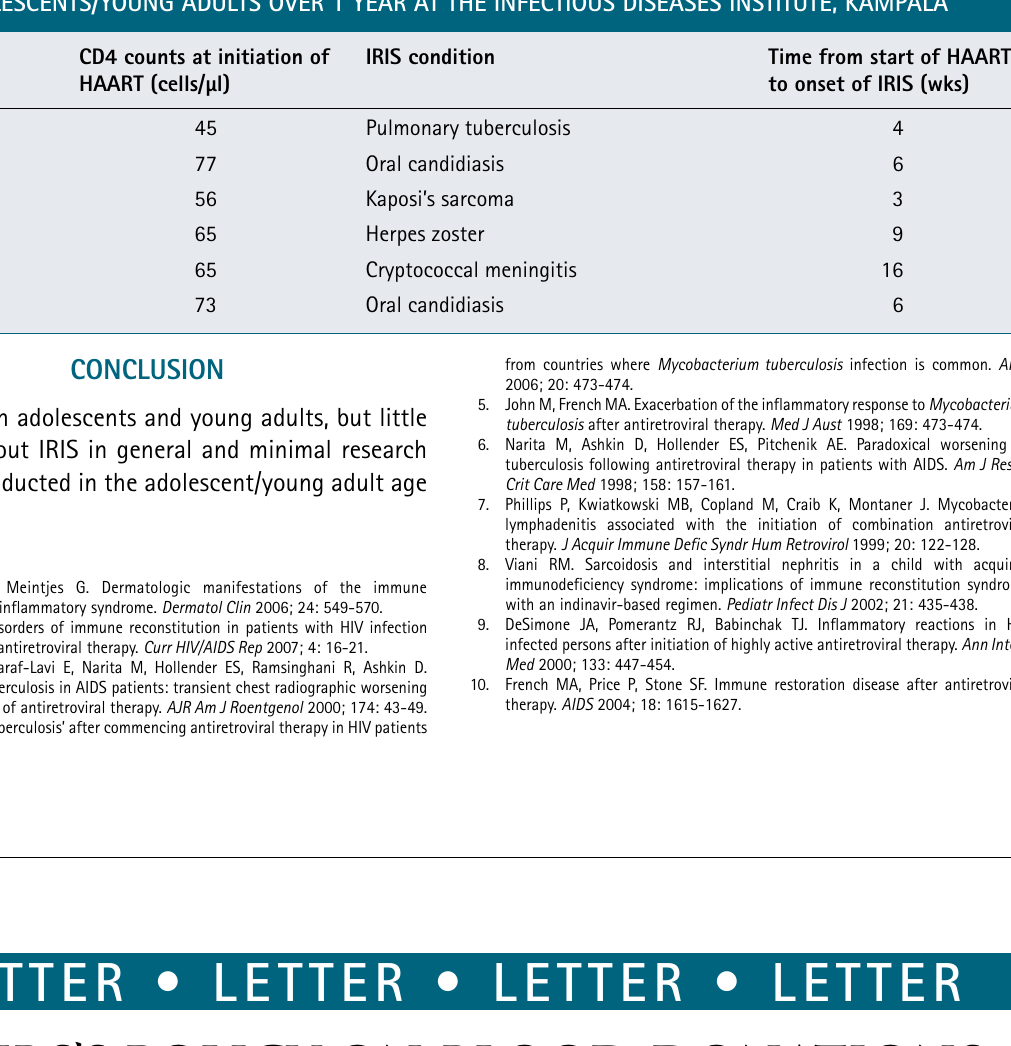
table i. table diSplaying ageS, abSolute cd4 countS and preSentation time oF iriS